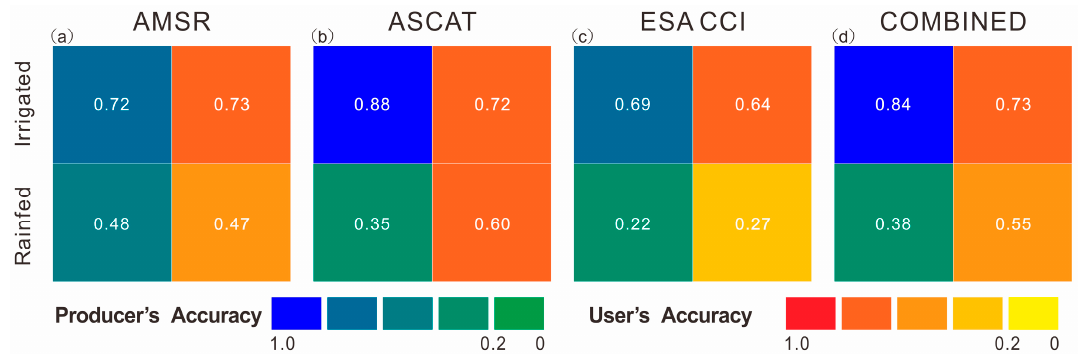
Figure 7. Confusion matrices of clustering from three microwave-based soil moisture products and the simple combination of both AMSR and ASCAT.